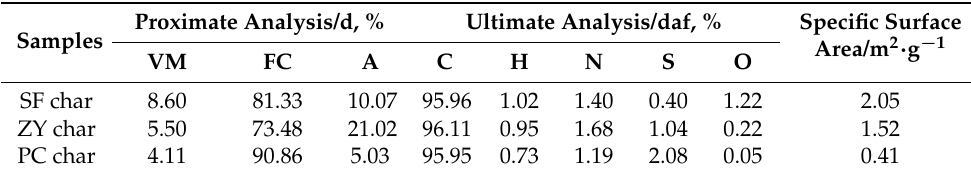
Table 1. Properties of tested char